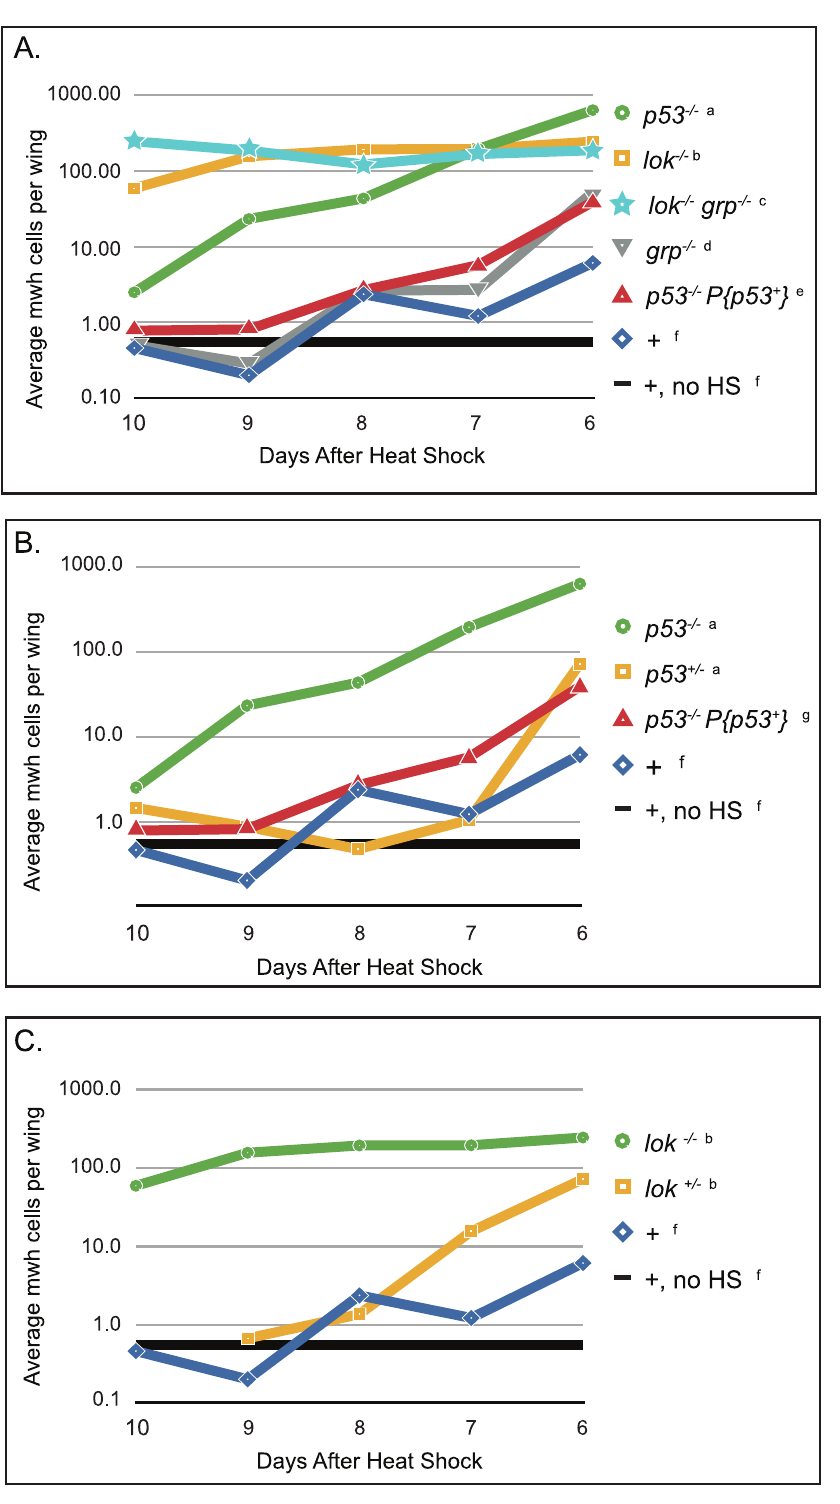
Figure7. Cell survival after telomere loss at different time points in development. Wings were scoredbased on thenumberof days after heat shock that the flies eclosed (x-axis). The number and size of all mwh clones were scored and the product of those numbers is reported here, averaged over the number of wings scored (y-axis). Flies that were collected 6 days after heat shock experienced telomere loss late in development, as approximately third instar larvae, and flies that were collected 10 days after heat shock experience telomere loss early, as approximately embryos or hatching larvae. Genotypes of female progeny are listed, males were also counted. (A) Survival of mwh cells in wild type and homozygous mutant flies; (B) lok + / 2 heterozygous effect, and (C) p53 + / 2 heterozygous effect. a. y w; Dc3(2xRS61A5)1A p53 5A-1-4 males X w 1118 hsFLP1; mwh p53 5A-1-4 females, progeny scored were y w/w 1118 hsFLP1; Dc3(2xRS61A5)1A p53 5A-1-4 /mwh p53 5A-1-4 . b. y w ; lok p6/p6 ; Dc3(2xRS61A5)1A males X w 1118 hsFLP1;lok + /p6 ; mwh females, progeny scored were y w/w 1118 hsFLP1 ; lok p6/p6 ; Dc3(2xRS61A5)1A/mwh and y w/w 1118 hsFLP1 ; lok + /p6 ; Dc3(2xRS61A5)1A/mwh , respectively. c. y w ;